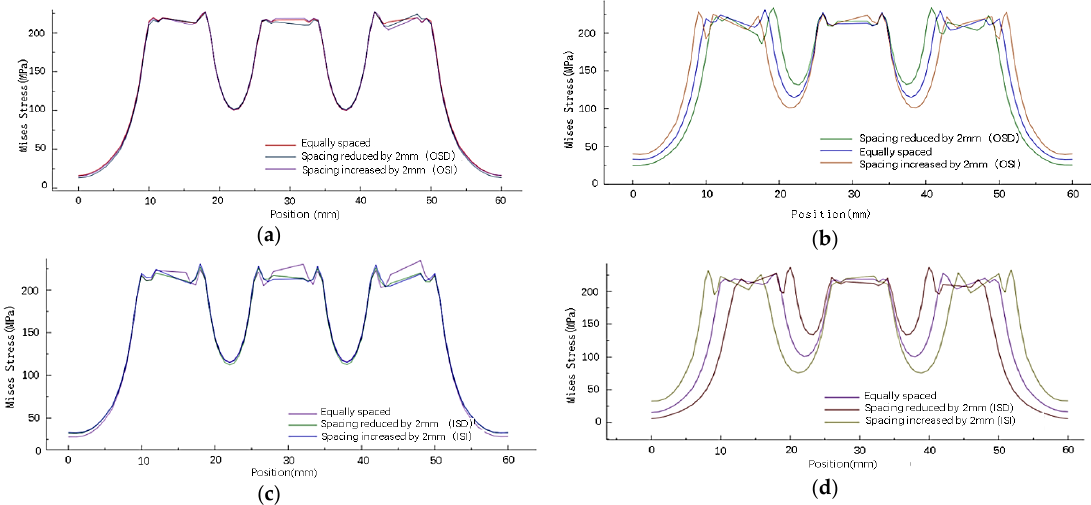
Figure 8. Mises stress distribution around the hole in the wall with different rivet spacing: ( a ) Mises stress distribution around the hole of path1 sheet under changes in the outer rivet spacing; ( b ) Mises stress distribution around the hole of path2 sheet under changes in the outer rivet spacing; ( c ) Mises stress distribution around the hole of path2 sheet under changes in the inner rivet spacing; ( d ) Mises stress distribution around the hole of path1 sheet under changes in the inner rivet spacing.